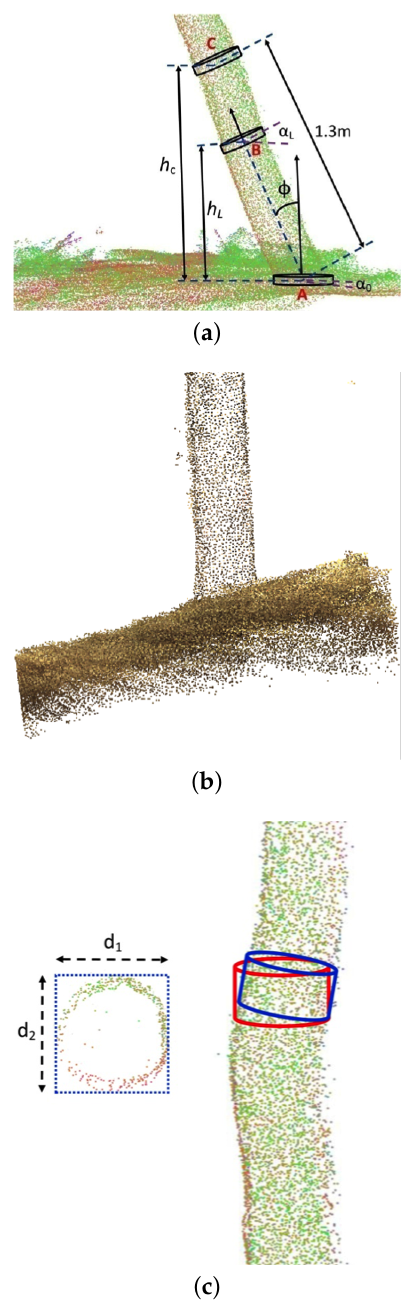
Figure 9. ( a , b ) show the case of a sloping tree on a horizontal ground and a vertical tree on a sloping ground, respectively. In ( c ) we can see the local deformation/deviation which can lead to erroneous diameter